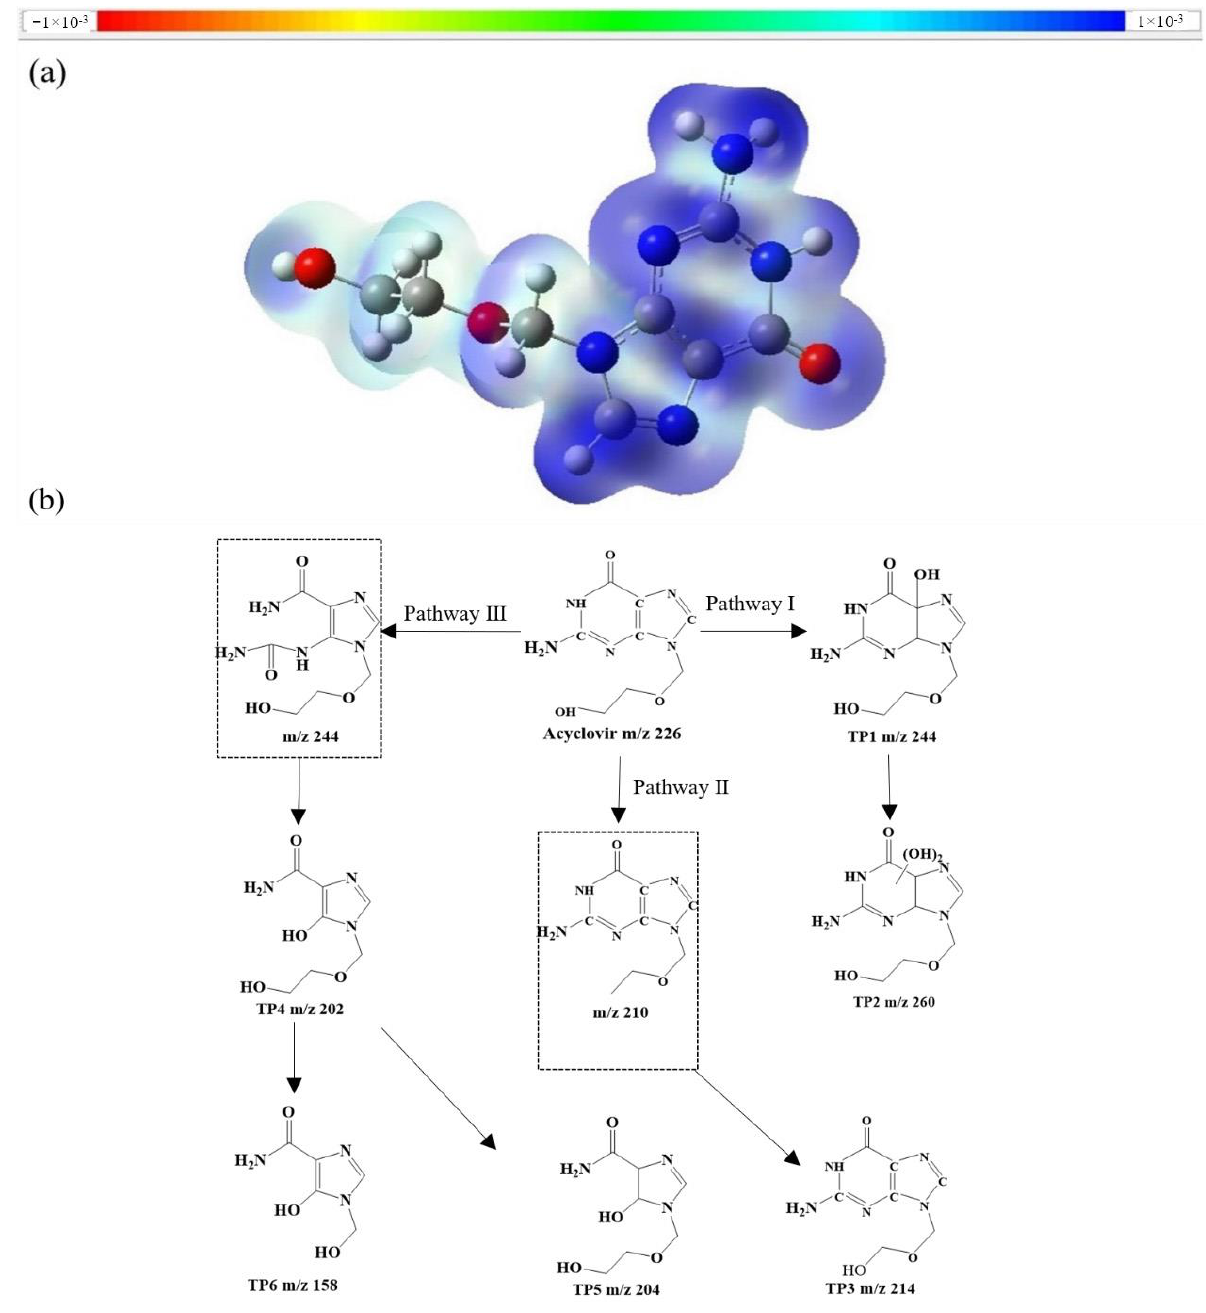
Figure 7. The contour surfaces of Fukui function f 0 for ACY with isovalue of 0.01 ( a ) and the plausible transformation pathways of ACY in UV/PDS process ( b ). Conditions: [ACY] 0 = 0.022 mM, [PDS] 0 = 0.6 mM, pH = 6.0.